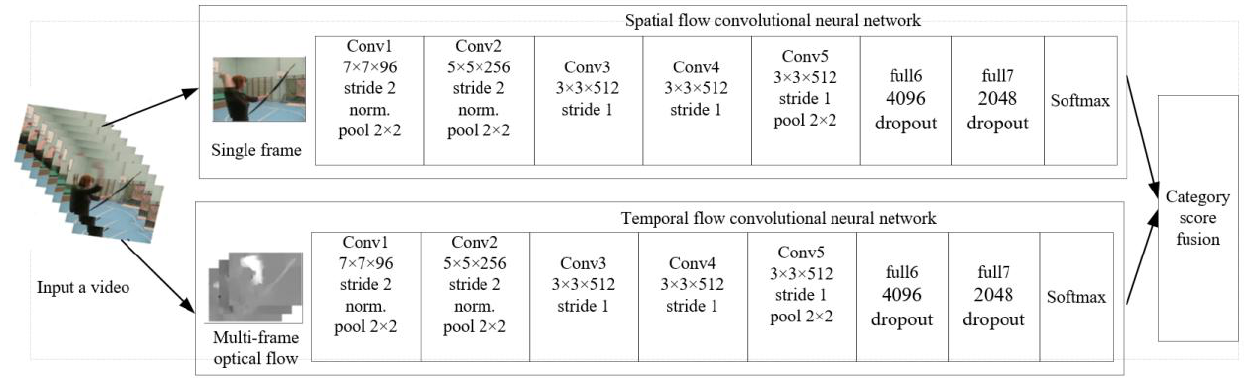
Figure 1. Two-stream network